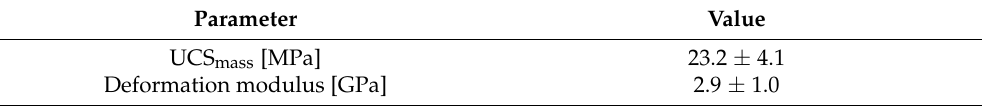
Figure 8. ( a ) Stress–strain curve for the fractured rock mass, including the evolution of number of cracks; ( b ) Displacement field of the calculated model with fracture traces of the incorporated DFN model shown in black. Table 7. Results of the rock mass properties using the LS-SRM model in combination with the DFN